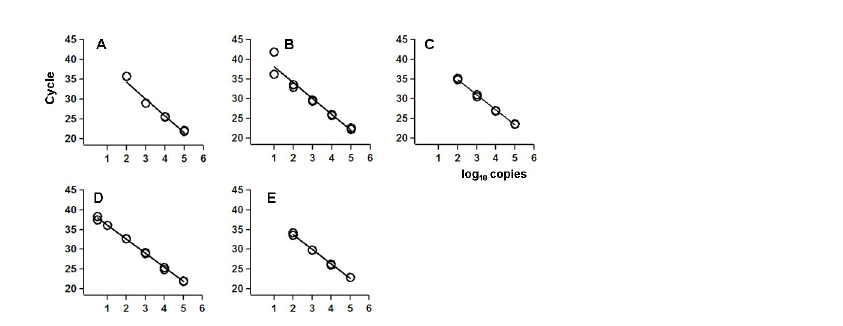
Fig 2. Analysis of the detection limit with each buffer. The amplification plot of each buffer with MM4 andM1pol Tth was obtained. Standard synthetic RNA was used as the template at 10 5 , 10 4 , 10 3 , 10 2 , 10, and 5 copies per reaction. The sample buffers used were as follows, A. Buffer 1, B. Buffer 2, C. Buffer 3, D. Buffer 4, and E. Buffer 5.